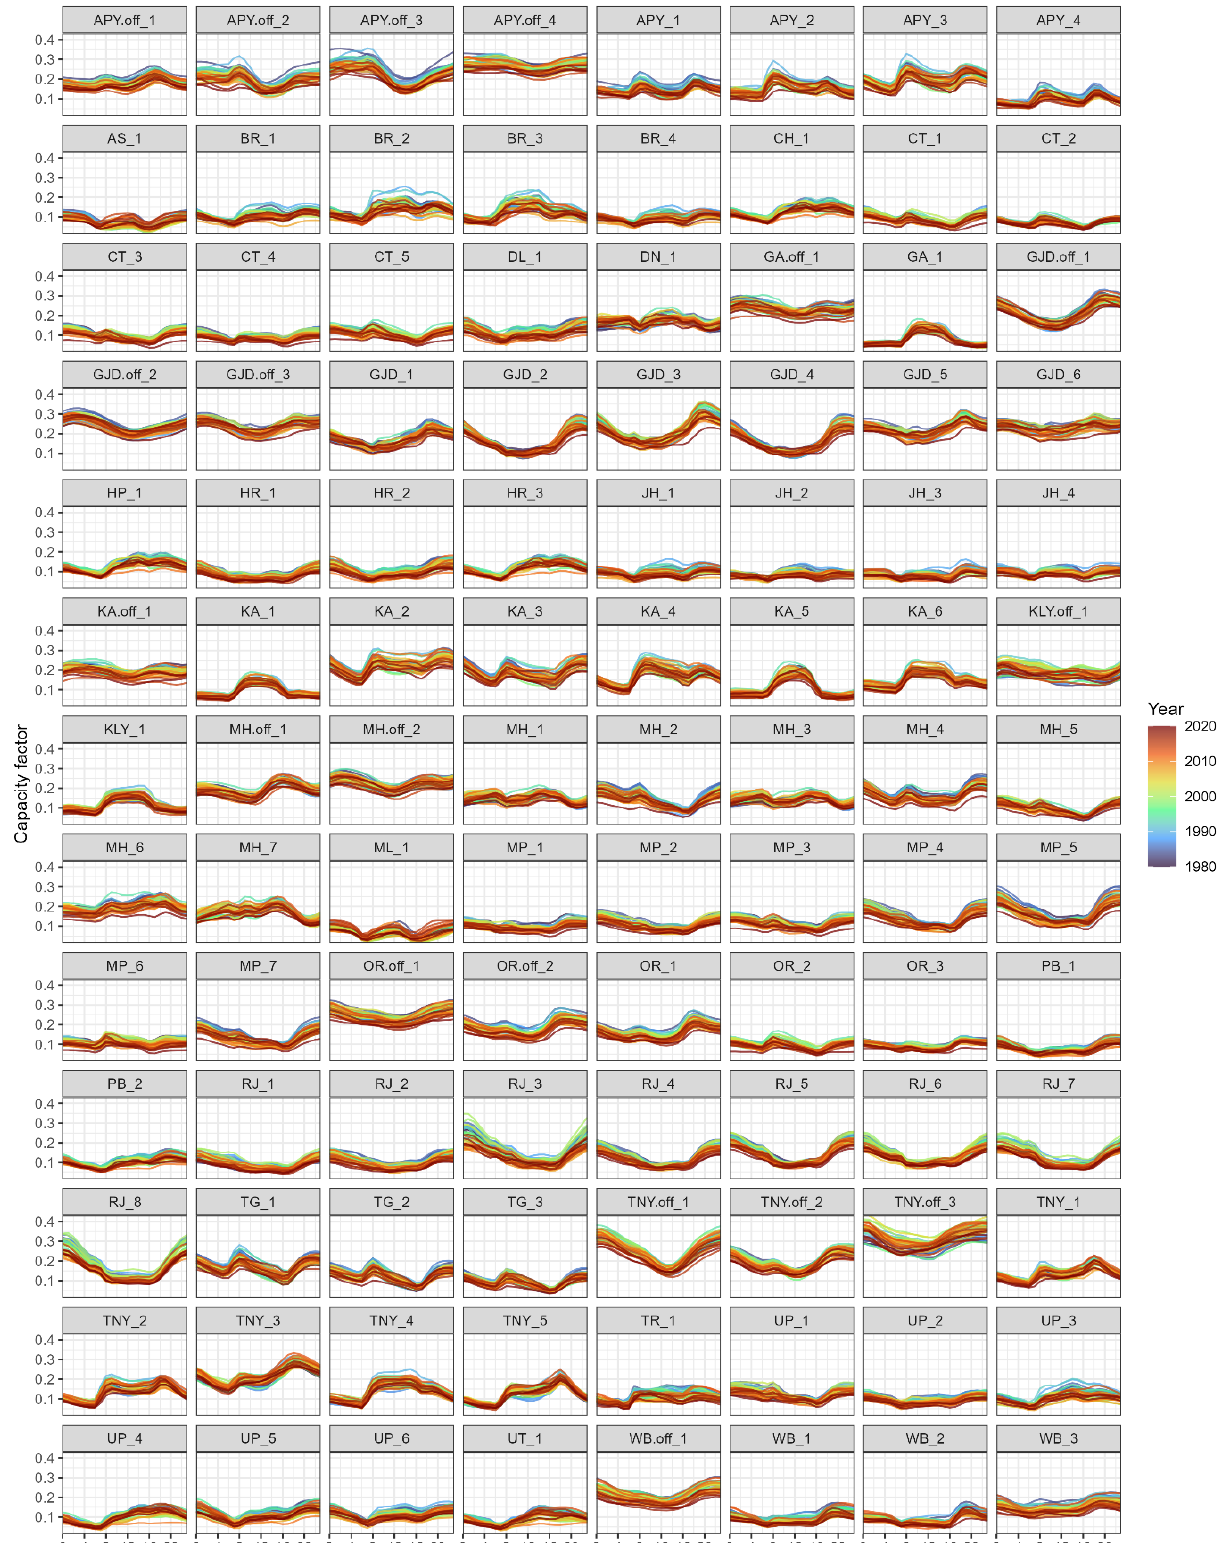
Figure A5. Annual average generation profile of wind turbines by year and cluster, onshore and offshore (.off) locations. Note: The figure demonstrates relative consistency in diurnal wind speed profile during a year in different locations (territorial wind clusters).